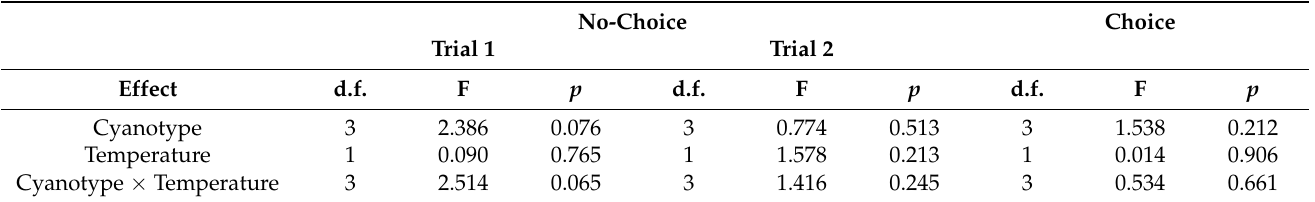
Table 1. Results from linear models examining how cyanotype, temperature, and their interaction affect herbivory in no-choice and choice assays of Trifolium repens leaves.